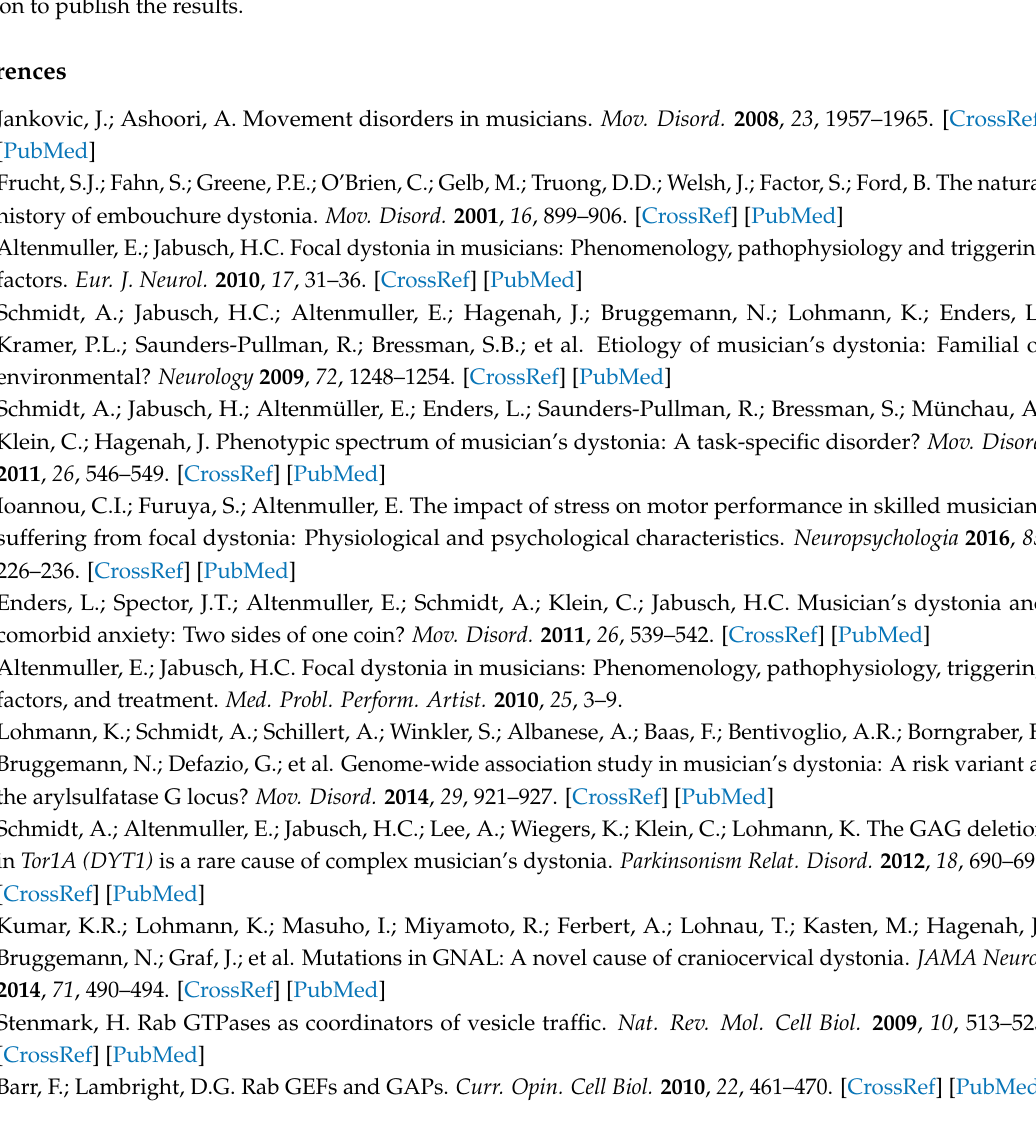
Figure S1: Photograph of Individual L-10289 (mildly affected mother of the index patient from Family D); Figure S2: TFRC colocalized with wildtype and mutant FLAG-RAB12; Figure S3: Lysosomal degradation of the physiological dimeric TFRC was not affected by the RAB12 mutations; Figure S4: Relative LC3-II protein levels are marginally increased in SH-SY5Y cells overexpressing RAB12 Gly13Asp protein and p62 levels remained constant; Figure S5: Original Blots of Figure 3a. Table S1: Demographic data of 604 other dystonia patients tested for mutations in the RAB12 gene; Table S2: Initial NGS variant calls; Table S3: Filter steps of variants generated